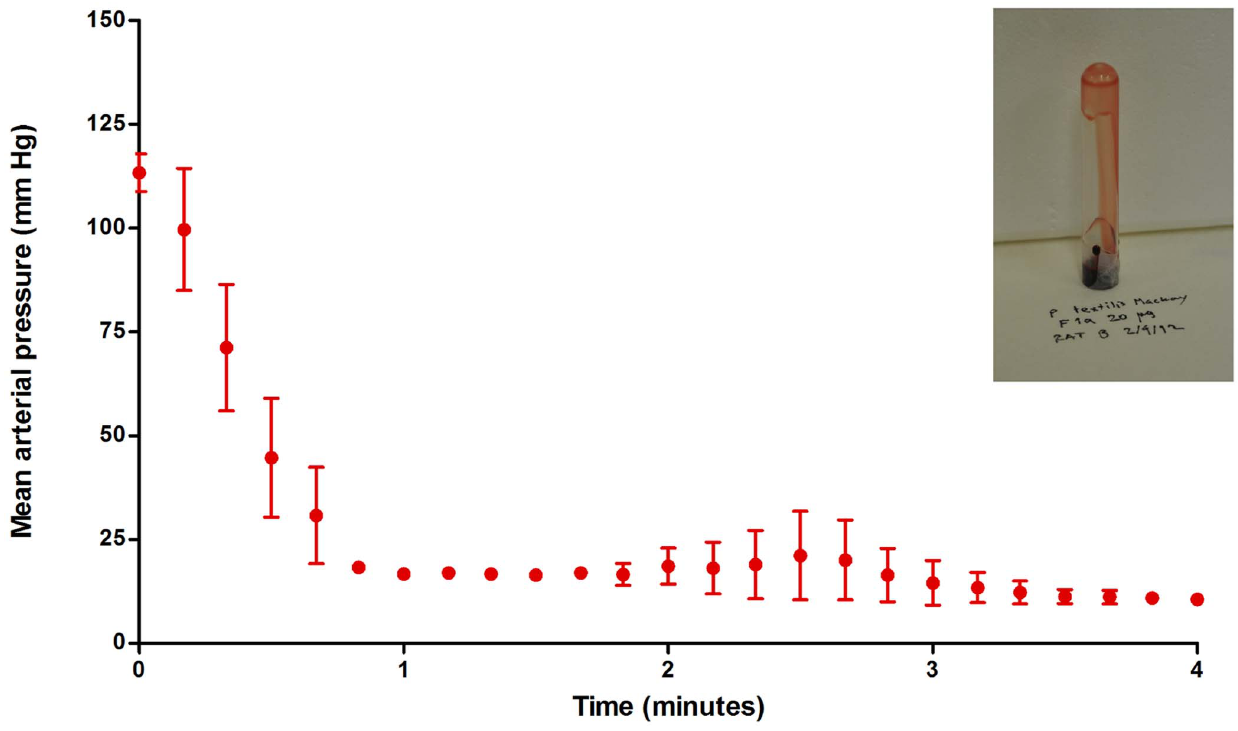
Figure 5. Mean arterial blood pressure in rats injected intravenously P.textilis (Mackay) venom prothrombin activator proteins. 20 m g of the HPLC size-exclusion fraction containing proteins matched by LC-MS to Q7SZN0, Q56VR3 and Q1L658 was injected in the jugular vein of pentobarbitone-anaesthesised rats. 20-minute whole blood clotting test confirmed coagulopathic activity of the toxins. Injection volume: 100 m l, vehicle: saline.